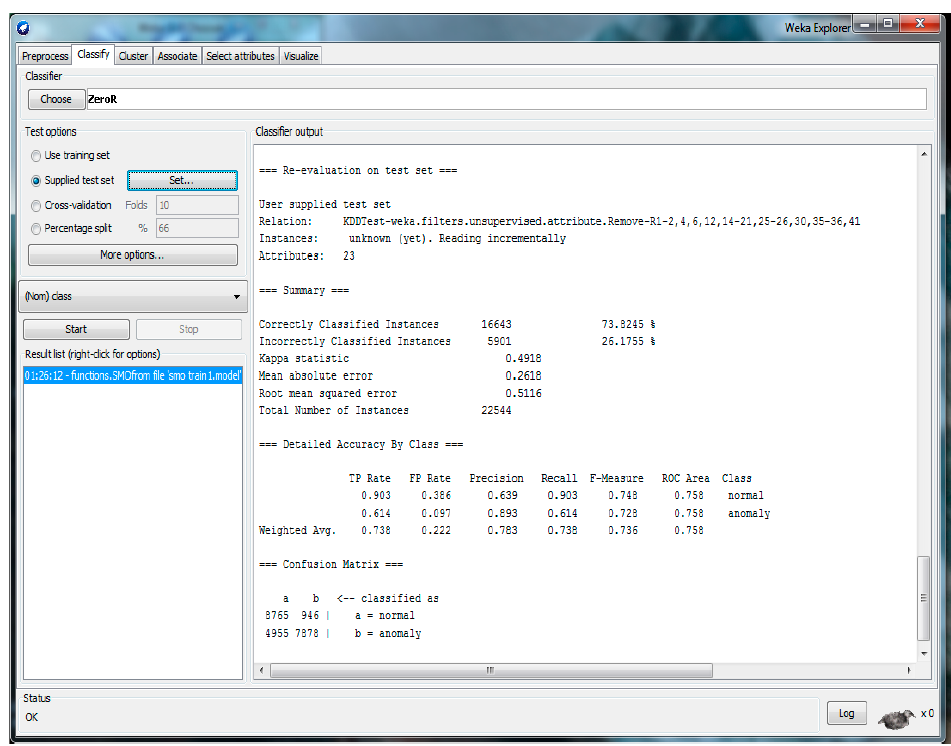
Table 4, one can calculate: